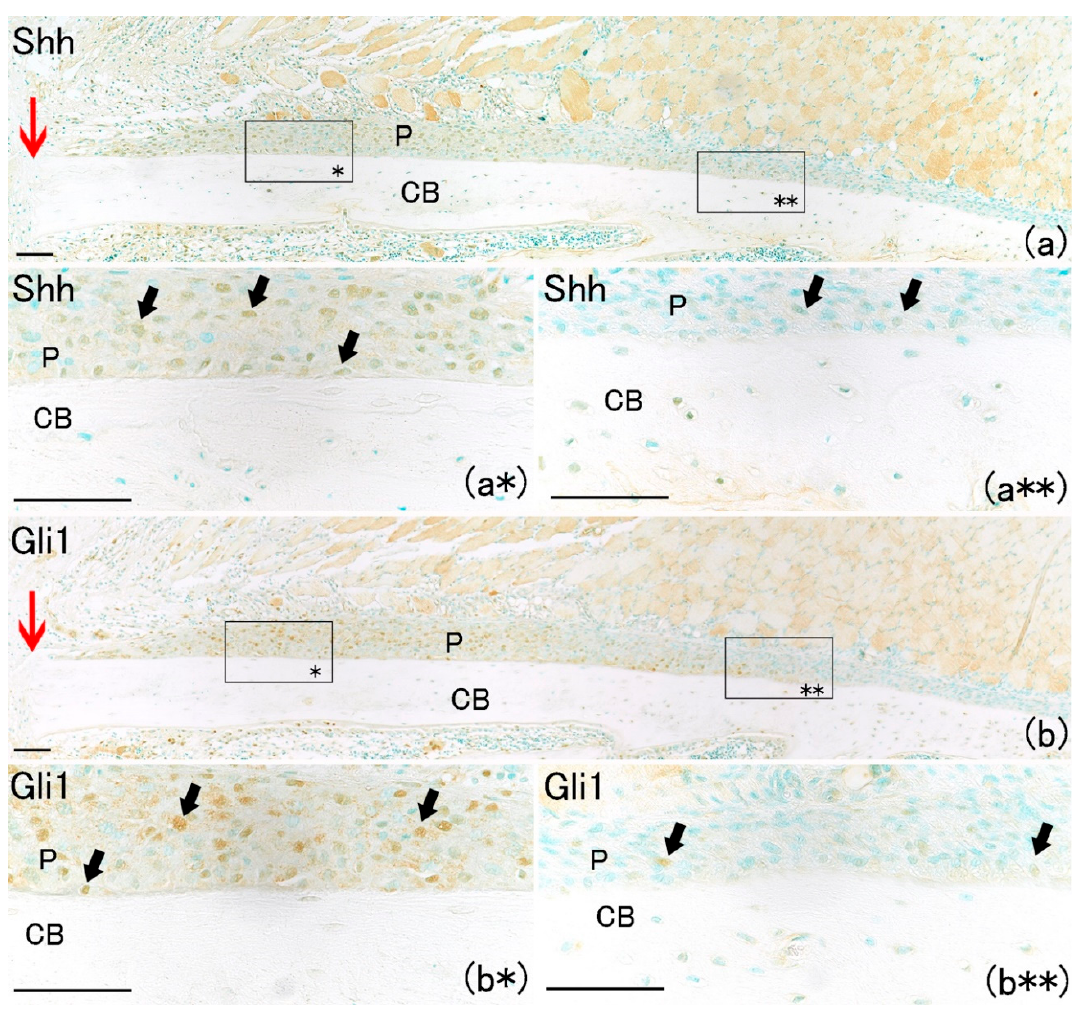
Figure 4. Histological analysis at day 1 on rat lib bone fracture (red arrow). ( a ) Shh-positive cells were observed in remaining periosteum. Scale bar: 100 μ m. ( a* ) Shh-positive expression near the fracture site (arrows). Scale bar: 50 μ m. ( a** ) Shh-positive cells were rarely observed far from the bone fracture site. Scale bar: 50 µ m. ( b ) Gli1-positive cells were observed in remaining periosteum. Scale bar: 100 µ m. ( b* ) Gli1-positive cells near the fracture site (arrows). Scale bar: 50 µ m. ( b** ) Gli1-positive cells were rarely observed far from the bone fracture site. Scale bar: 50 μ m.